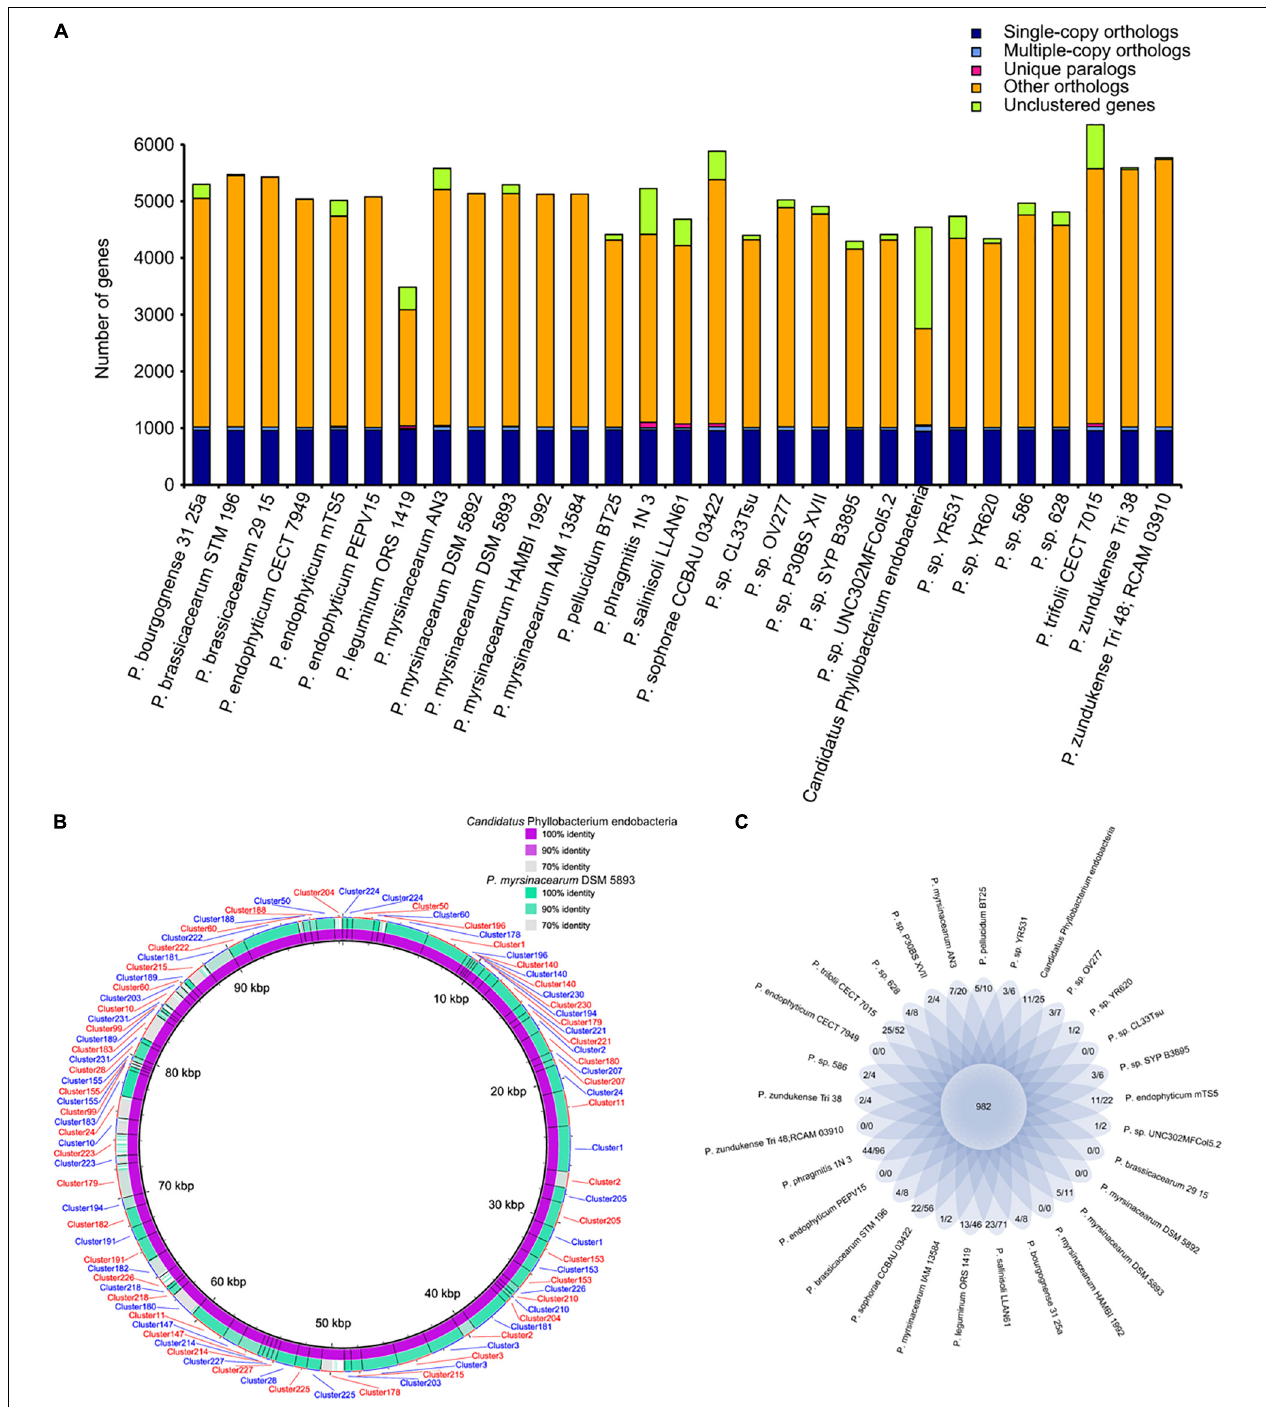
FIGURE 3 | Gene family of the endobacteria living in Esteya vermicola and its 28 related species. (A) Statistical graph of homologous gene number of the endobacteria and 28 completely sequenced Phyllobacterium . Single-copy orthologs, single copy homologous genes in the gene families shared among species; multiple-copy orthologs, multicopy homologous genes in gene families shared among species; unique paralogs, genes of the strain unique to the family; other orthologs, all other genes; unclustered genes, genes not clustered into any family. (B) BLAST ring image of multiple copy genes in the genome of the endobacteria living in E. vermicola , in comparison with the closest Phylobacterium genomes - P. myrsinacearum DSM 5893, indicating the endobacteria having more multiple copy gene family (42). (C) Flower plots showing the common gene family number (in the center) and strain-specific gene family number/gene number within strain-specific gene families (in the petals) in the endobacteria living in E. vermicola and its 28 related Phyllobacterium species.